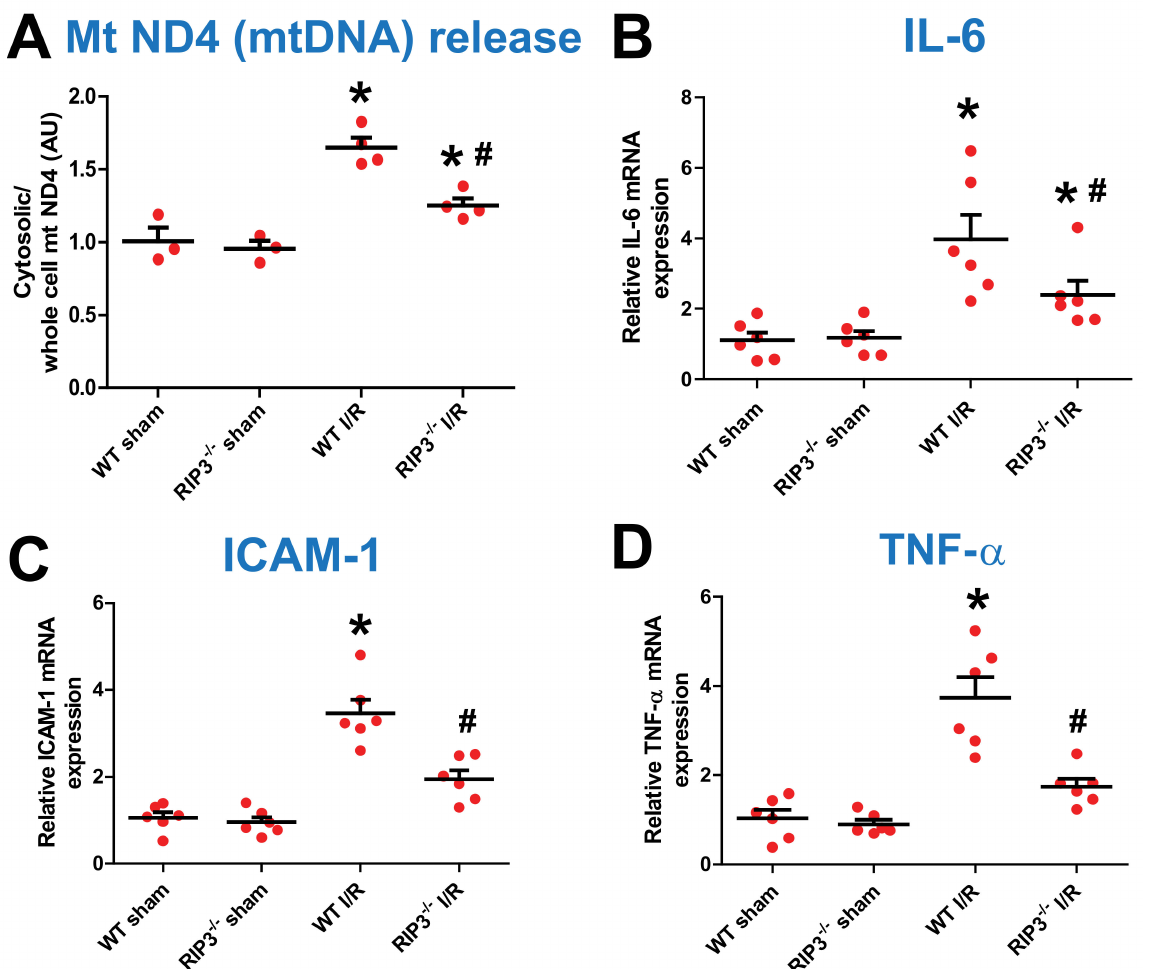
Figure 6. RIP3 − / − mice exhibit decreased mtDNA release and inflammation after renal I/R. ( A ) Graph showing an increase in mitochondrial DNA (mtDNA) release in the cytosol in WT mice after renal I/R compared with the sham-operated animals. However, in RIP3 − / − mice, the release of mtDNA was reduced when compared to littermate WT mice after renal I/R. Note that there was no difference in mtDNA levels between WT and RIP3 − / − sham mice. Values are expressed as means ± SEM; * p < 0.05 versus WT sham group, # p < 0.05 versus WT-I/R ( n = 4/group). ( B – D ) Graph showing increases in pro-inflammatory markers including IL-6, ICAM-1, and TNF-6 levels in the cytosol in WT mice after renal I/R compared with the sham-operated animals. However, in RIP3 − / − mice, the release of these pro-inflammatory markers was reduced when compared to littermate WT mice after renal I/R. Note that there was no difference in pro-inflammatory markers between WT and RIP3 − / − sham mice. Values are expressed as means ± SEM; * p < 0.05 versus WT sham group, # p < 0.05 versus WT-I/R ( n =